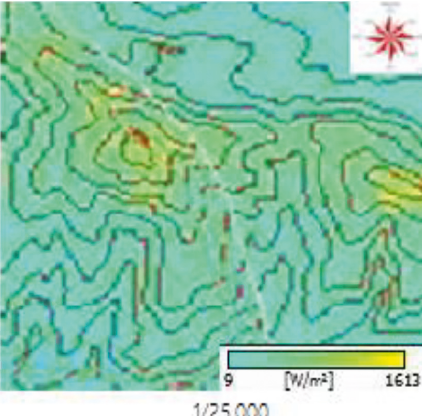
Figure 7: Power density map of the area.